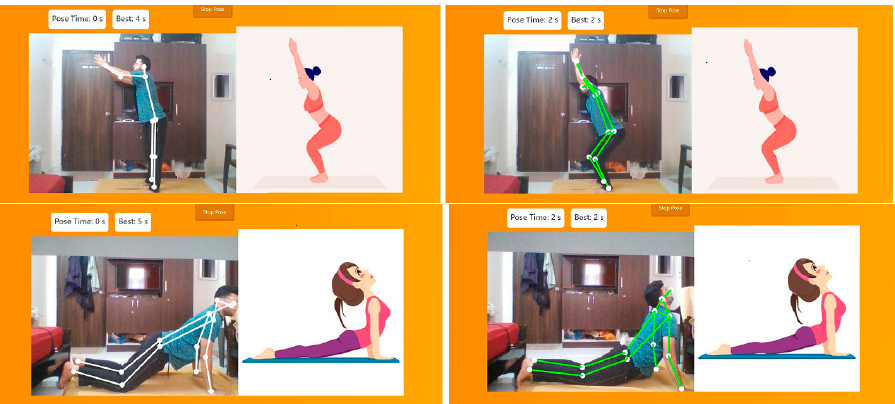
Figure 16. Sample output indicating incorrect pose (white connections) and user on the fly making adjustments until the correct pose (green connections) is attained.